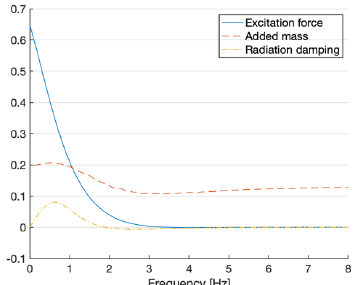
Figure 4. The following hydrodynamic coefficients contributed to the wave input: non-dimensionalized surge on excitation force and added mass and heave coefficients of radiation resistance.